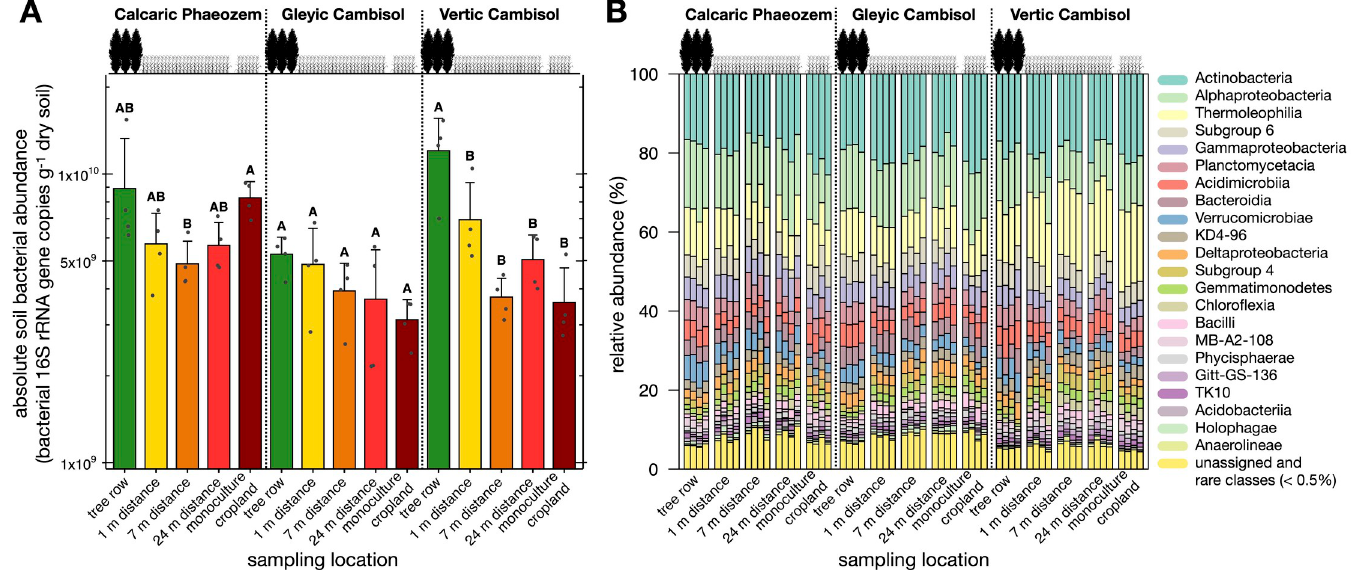
Fig 3. 16S rRNA gene abundance of soil bacteria ( A ) and relative abundance of taxonomic groups of soil bacteria at class level ( B ) in paired temperate agroforestry and monoculture cropland systems in three different soil types. Samples in the agroforestry systems were collected in the tree row as well as at 1 m, 7 m, and 24 m distance from the tree row within the agroforestry crop row. Bars represent means with standard deviation ( n = 4 per soil type × sampling location) ( A ). Different uppercase letters indicate significant differences among the sampling locations (one-way analysis of variance with Tukey’s honestly significant difference test or Kruskal–Wallis test with multiple comparison extension) ( A ). Soil bacterial classes with an overall relative abundance of < 0.5% were considered as rare classes and merged with unassigned classes ( B ).